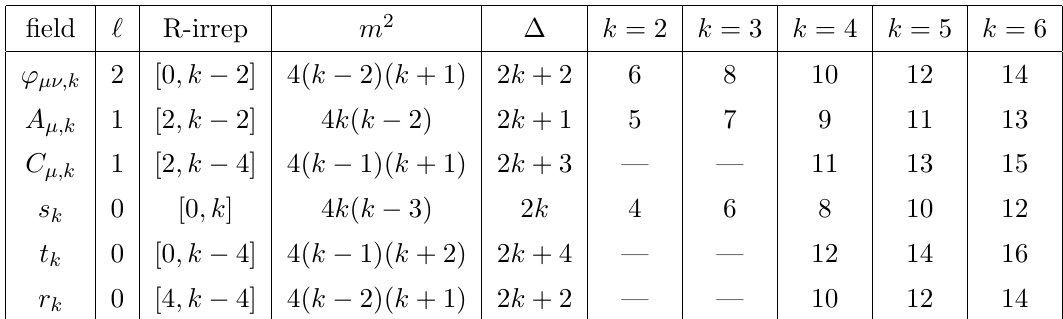
Table 1 . KK modes contributing to exchange diagrams allowed by R-symmetry selection